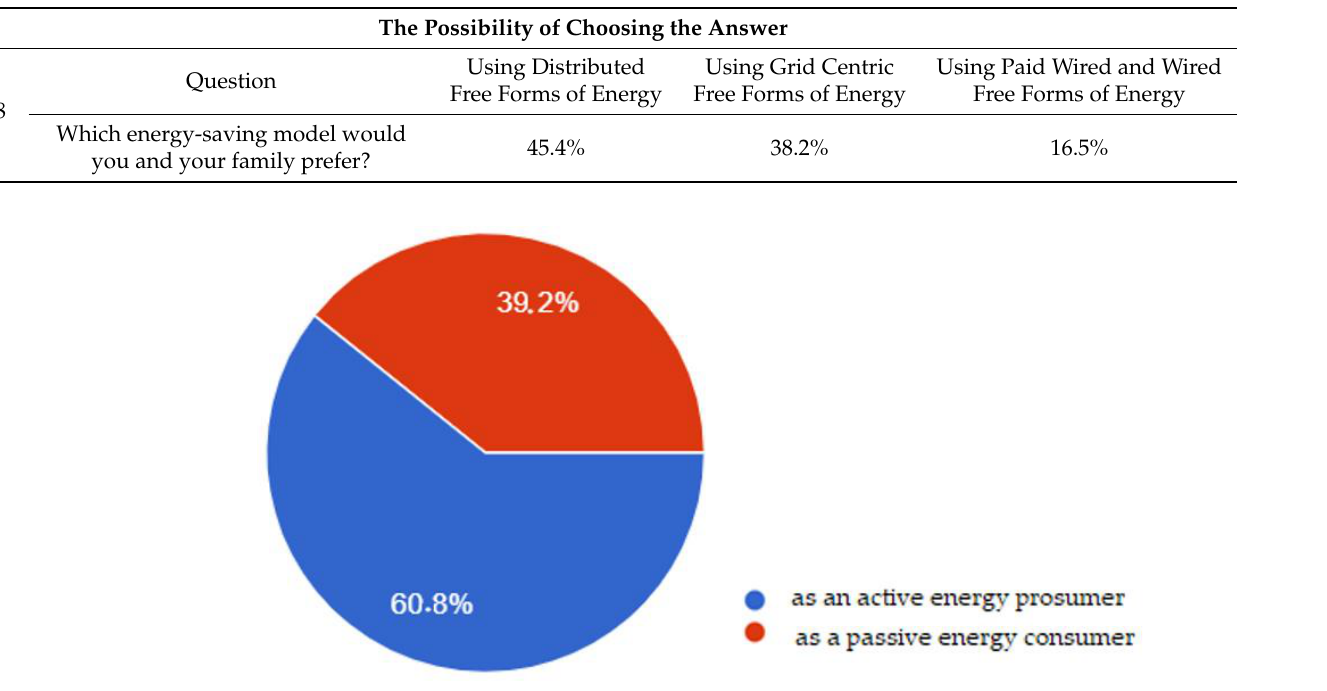
Table 10. Question no. 10, research results.